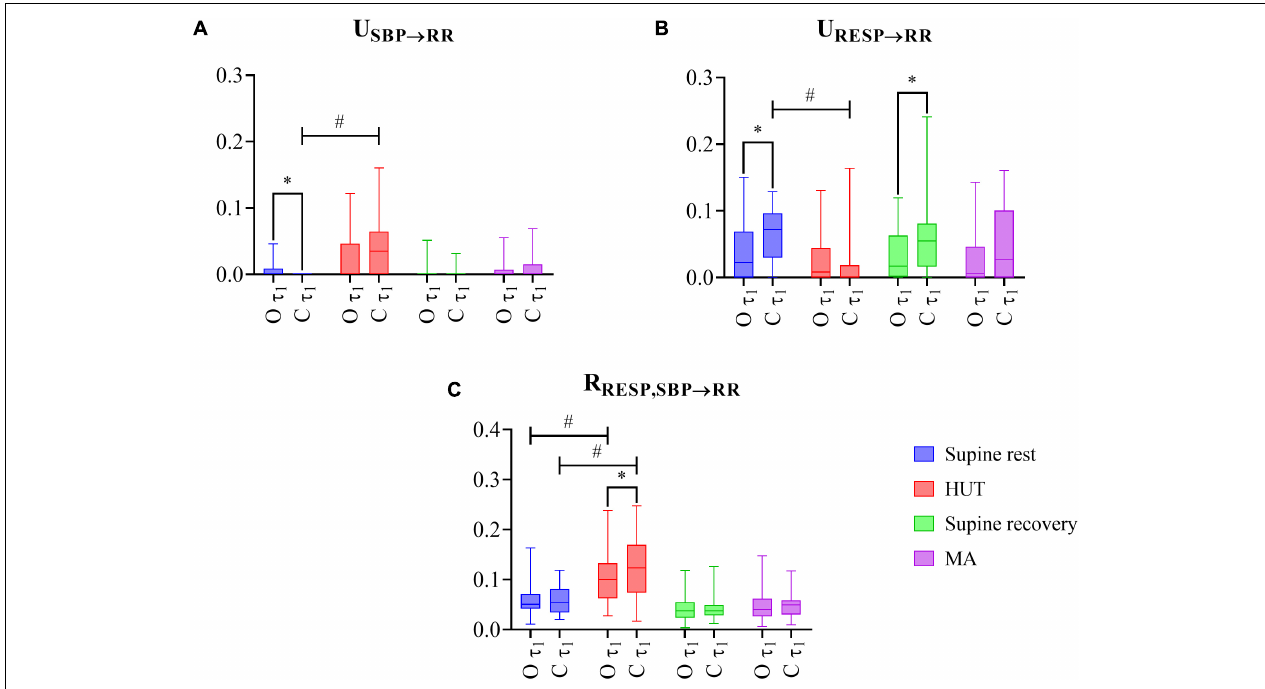
FIGURE 2 | The results of multiscale information decomposition during four phases (rest, HUT, supine recovery, and MA) calculated for the raw (non-filtered) data ( τ 1 ) for the group of obese (O) and healthy non-obese control (C) adolescents and young adults. Graphs represent distribution of values in box plots for: (A) unique transfer entropy from SBP to RR (U SBP → RR ) and (B) from RESP to RR (U RESP → RR ), and (C) redundant transfer entropy (R RESP , SBP → RR ) * indicates a statistically significant difference between the group of obese and healthy subjects and # represents a statistically significant difference between preceding rest phase and physiological stress (orthostasis or mental arithmetics